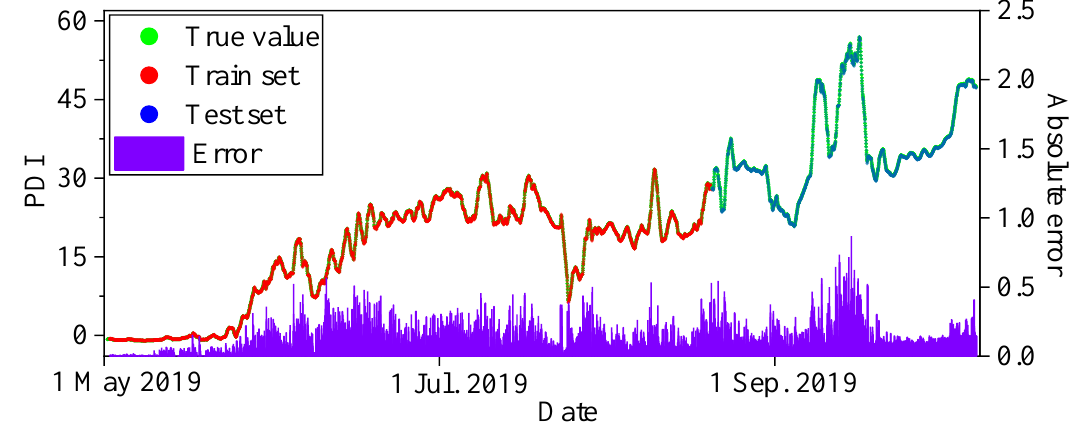
Figure 15. Prediction result of the TPA-LSTM.